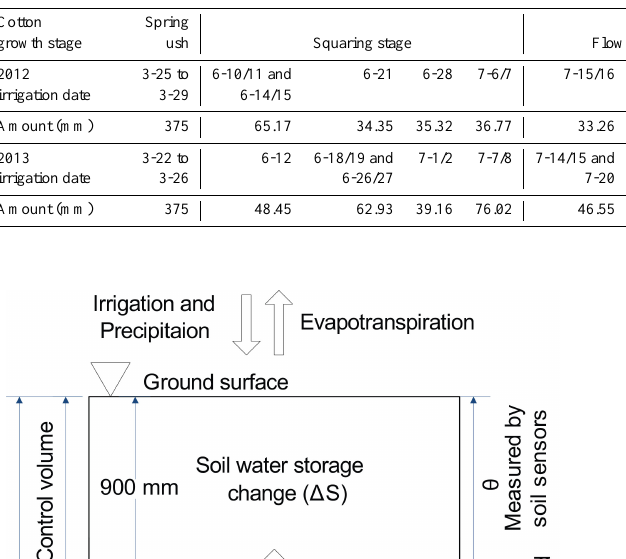
Table 1. Irrigation schedule.